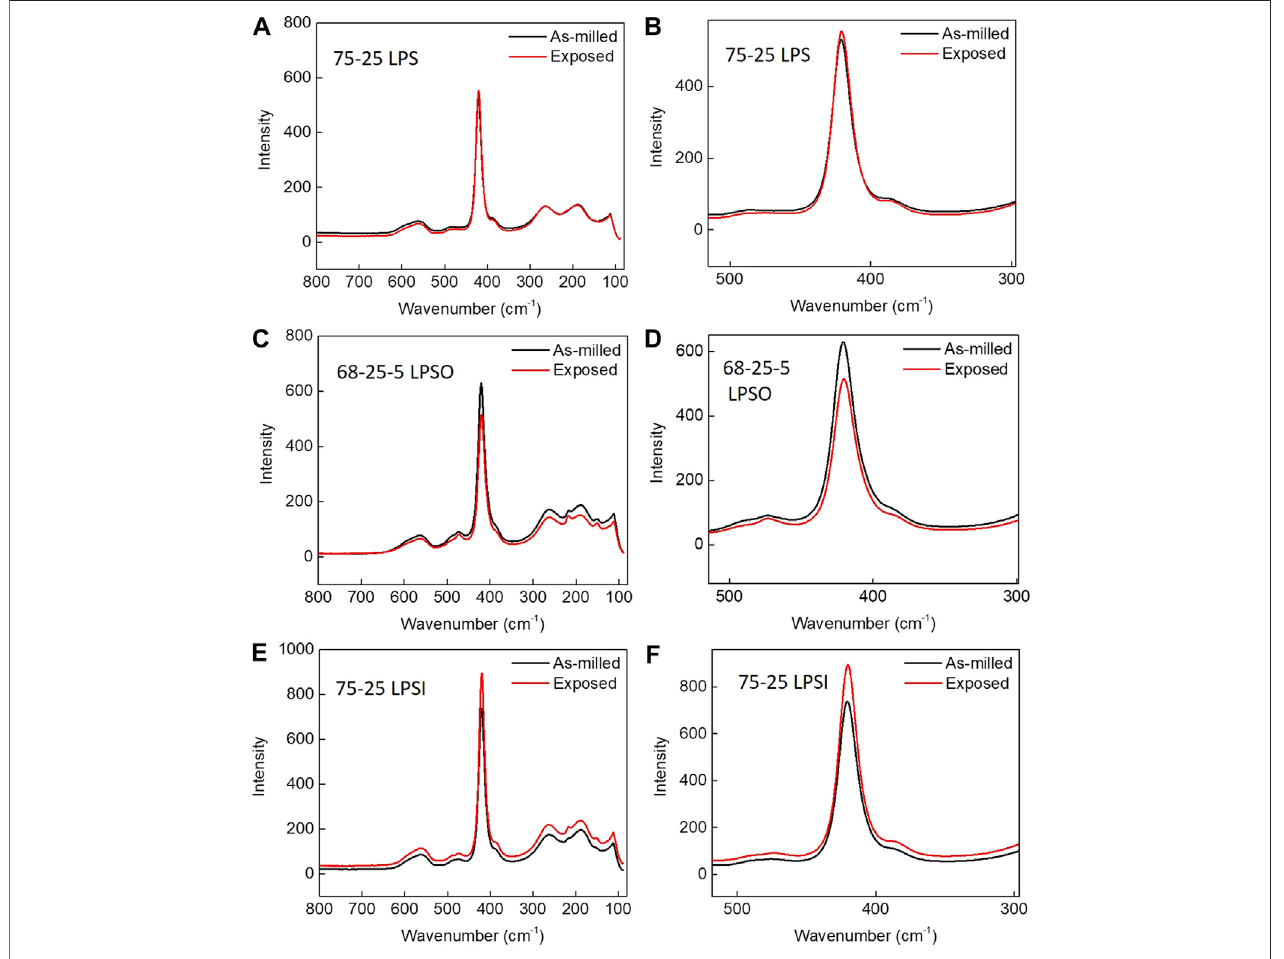
FIGURE 6 | Raman spectroscopy spectra for 75-25 LPS, 7-68-25 LSPO, and LPSI sul fi de SSEs before and after exposure to a − 40 ° C dew point dry room for 30 min.